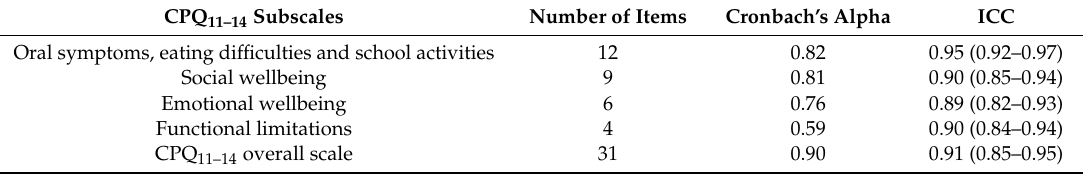
Table 2. Reliability statistics for the subscales and total scale of the Hindi translation of CPQ 11–14. CPQ 11–14 Subscales Oral symptoms, eating di ffi culties and school